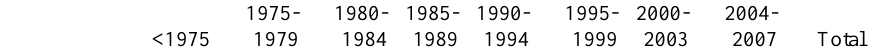
Descriptive statistics for graduates for general teacher education (GTE) and post- graduate teacher education (PGCE), by graduation